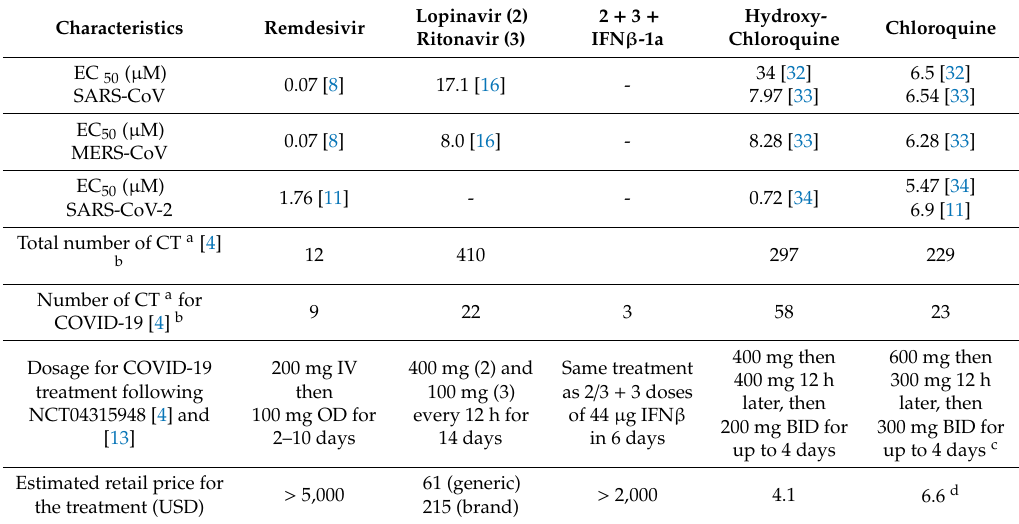
Table 2. Some noticeable characteristics of the four treatments considered in the Discovery project.